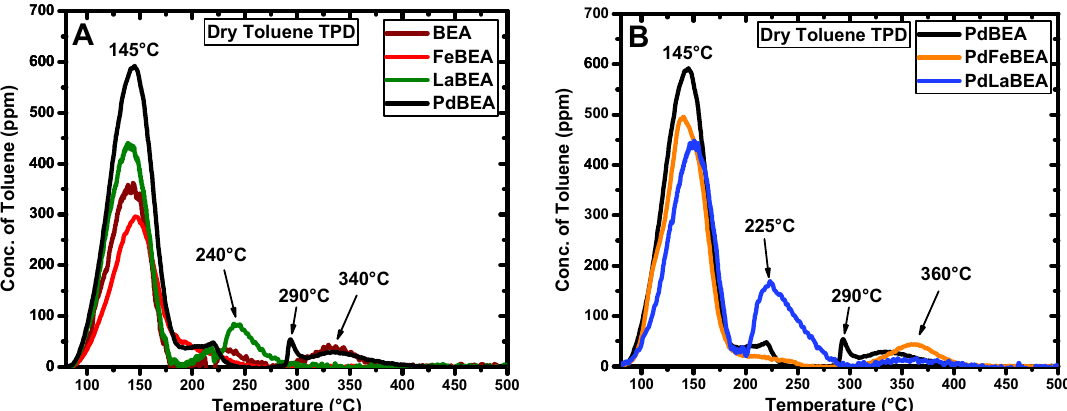
Figure 5. Temperature-programmed desorption of toluene in dry conditions where the concentration of toluene is plotted against the corresponding desorption temperature during the heating ramp for ( A ) BEA, Fe / BEA, La / BEA, and Pd / BEA; and for ( B ) Pd / BEA, Pd / Fe / BEA, and Pd / La / BEA.